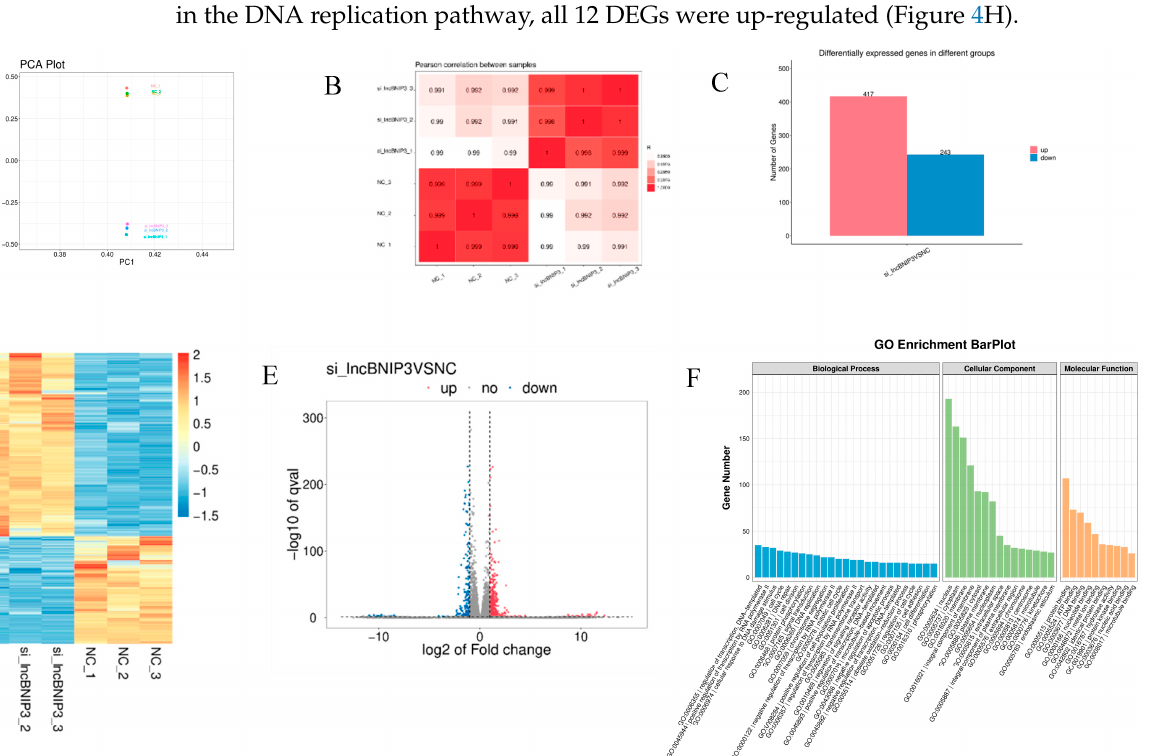
Figure 4. Identification and enrichment analyses of DEGs associated with lncBNIP3. ( A ) PCA Plot; ( B ) Pearson correlation coefficient cluster graph; ( C ) The number of up-regulated and down-regu- lated DEGs; ( D ) Heatmap for hierarchical cluster analysis of all sequencing samples and DEGs; ( E ) Volcano plot for the distribution of DEGs; ( F ) GO enrichment analysis results for DEGs; ( G ) KEGG enrichment analysis of DEGs; ( H ) Cyclic plots of the number of up-regulated and down-regulated DEGs in different enrichment pathways.